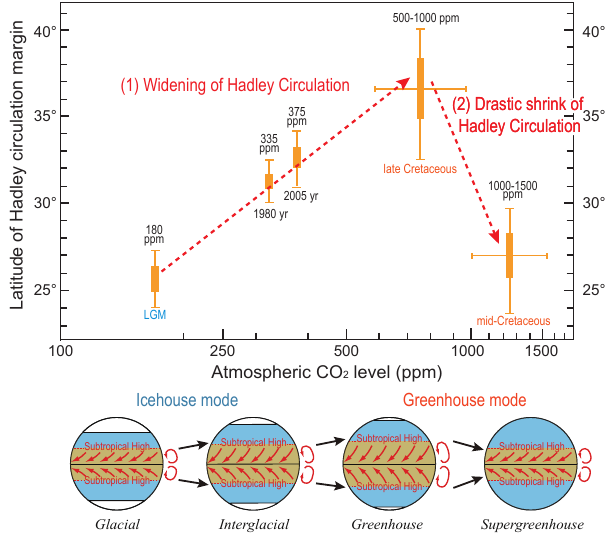
Fig. 5. Conceptual scheme of the latitudinal change in the subtrop- ical high-pressure belt versus atmospheric CO 2 levels. Also shown is the inferred evolutionary trend of the atmospheric circulation pat- tern (variations in the width of the Hadley circulation) in response to climatic warming (from icehouse mode to greenhouse mode). Values of atmospheric CO 2 during the middle and late Cretaceous are based on carbon cycle model estimates (Berner, 2006, GEO- CARBSULF) and proxy-based estimates (compiled by Breecker et al., 2010) (Fig. 4c). Latitudes of the subtropical high-pressure belt at the present-day and Last Glacial Maximum are based on recent observational studies (Hu and Fu, 2007; Seidel et al., 2008) and ge- ological data (Nicholson and Flohn, 1980; Toggweiler and Russell, 2008). Vertical bars indicate ranges in the latitude of the subtropi- cal high-pressure belt. Arrows in the lower figures represent trade